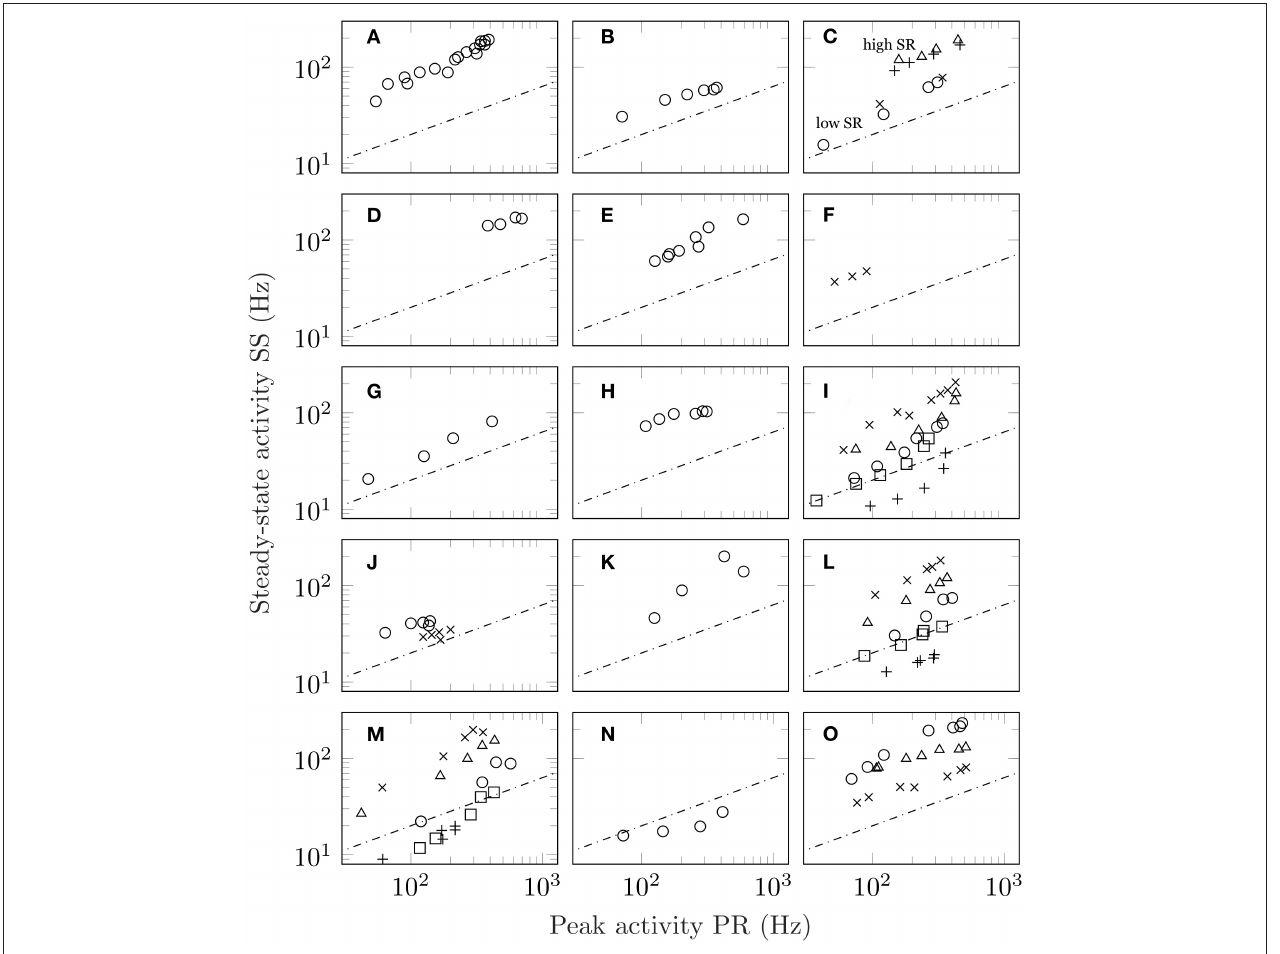
FIGURE 2 | Steady-state activity (SS) plotted as a function of peak activity (PR) for different stimulus intensities. In all panels, the dashed line shows the predictions of Equation (1) which is a line with slope one-half on a log-log plot with the value of SR set arbitrarily equal to 4. The actual value of intercept depends on the precise value of the unit’s spontaneous activity. (A) Plot of SS vs PR for auditory data taken from a single guinea pig fibre (figure 1, unit GP-17-4), Smith and Zwislocki (1975); (B) the same for auditory data from a single gerbil fibre (figure 1, unit E8F2), Westerman and Smith (1984); (C) results for four separate guinea pig auditory fibres of both high and low spontaneous activity (triangles, figure 1, unit GP31/08; plusses, figure 2, unit GP27/18; circles, figure 1, GP31/13; crosses, figure 2, GP27/04), Yates et al. (1985); (D) the averaged auditory data from ferrets (figure 6), Sumner and Palmer (2012); (E) auditory responses obtained from the saccular nerve fibres of a gold fish (figure 3, increment), Fay (1985); (F) responses from lateral line in fish (figure 6), Mogdans et al. (2017) (G) stretch response in crayfish (figures 1 and 2, both PR and SS are shifted upwards by 0.5 log units), Brown and Stein (1966); (H) stretch response in frog (figure 3, both PR and SS are shifted upwards by 1 log unit), Loewenstein (1956); (I) response of olfactory receptor neurons in fruit flies (figure 3a: crosses, shifted 0.3 log units; figure 5: triangles, shifted 0.1 log units, methyl + + butyrate; circles, shifted 0.1 log units, methyl butyrate; squares, shifted 0.3 log units, 1-pentanol; plusses, shifted 0.5 log units, propyl acetate), Martelli et al. − − − (2013); (J) taste recordings in fruit fly sensilla (circles, figure 3; crosses, figure 7), Gothilf et al. (1971); (K) taste response in caterpillar (figure 3), Bernays et al. (2002); (L) taste response in blowfly (figure 2a: circles, LiCl, shifted 0.2 log units; triangles, NaCl; crosses, KCl, shifted 0.2 log units; squares, RbCl, shifted 0.4 log units; + − − plusses, CsCl, shifted 0.6 log units), Maes and Harms (1986); (M) same as (L) but for figure 2b, Maes and Harms (1986); (N) response to cooling in beetles (figure − 10), Merivee et al. (2003); and (O) vision data from a single ON-centre ganglion cell in the cat. The vision data differ from the other auditory data in that they are derived from pre-adapted luminance values (figure 7: circles, 1 10 − 5 cd m − 2 , shifted +0.2 log units; plusses, 1 10 − 3 cd m − 2 ; crosses: 1 10 − 1 cd m − 2 , shifted 0.2 log × × × − units), Sakmann and Creutzfeldt (1969).